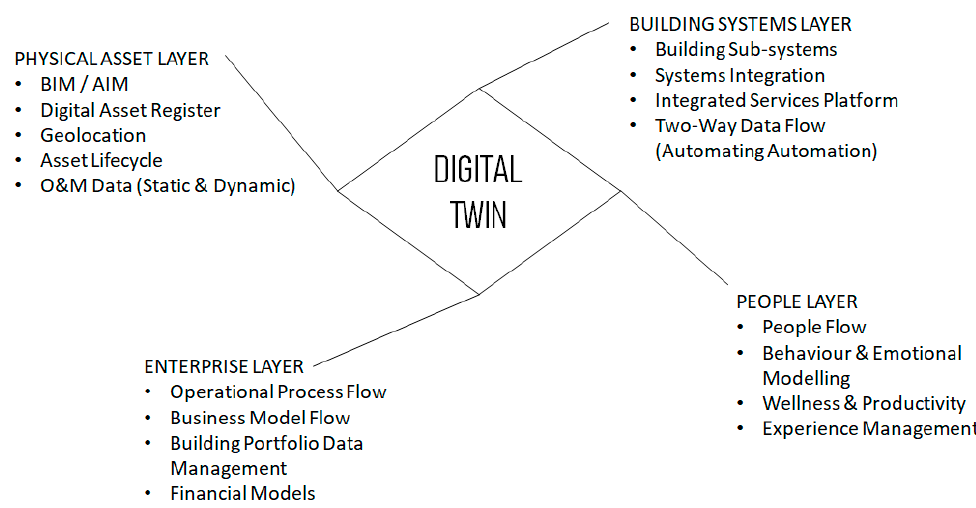
Figure 1. Digital Twin interpretation.